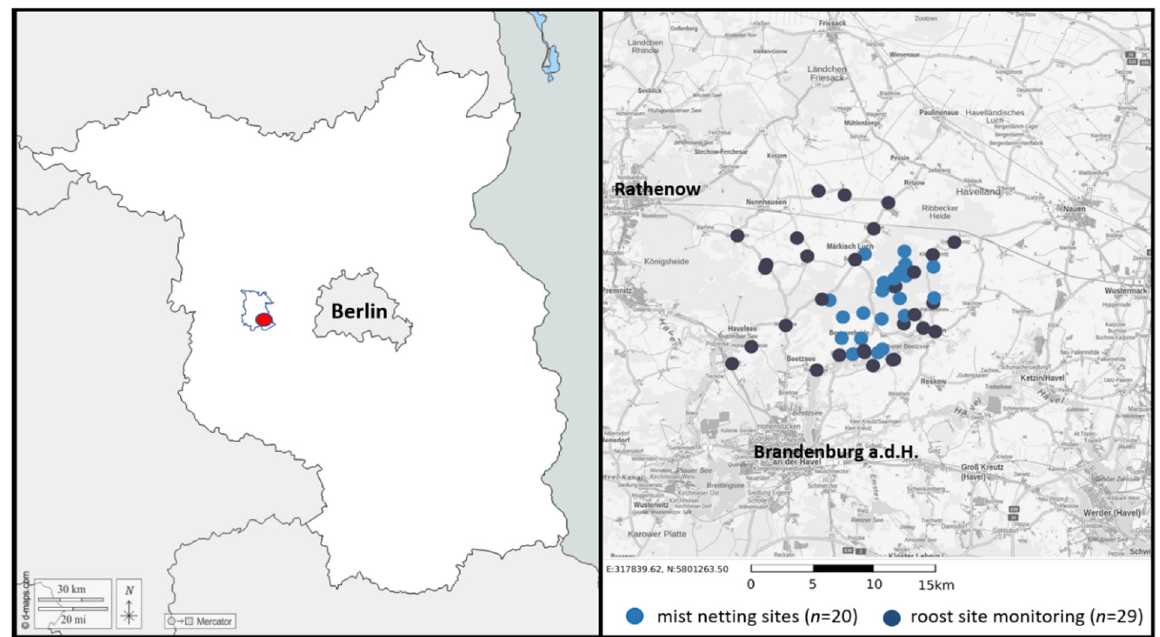
Figure 1. Left : Location of the study area (red dot) covering an area of approx. 100 km 2 within the Havelland (blue line). Right : Presence and distribution of P. auritus and P. austriacus in the study area was surveyed by systematically capturing bats with mist-nets at selected study sites ( n = 20) and systematically searching in possible roosting sites (i.e., churches, large agricultural holdings, and private houses; n = 29) between May and October 2012 and 2013.